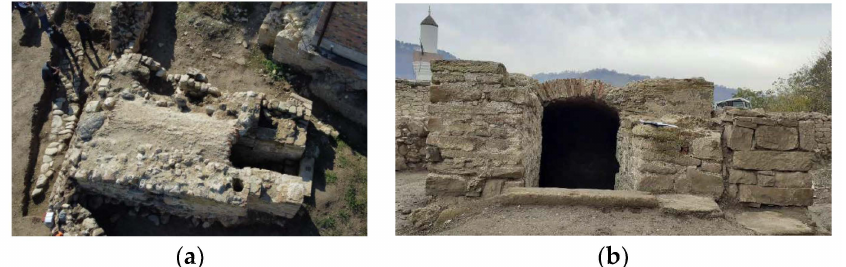
Figure 9. Baruthana. ( a ) Archeological site aerial view, ( b ) Baruthana entrance portal—view from outside (Photo source: private archive of Vladan Vidosavljevi´c).